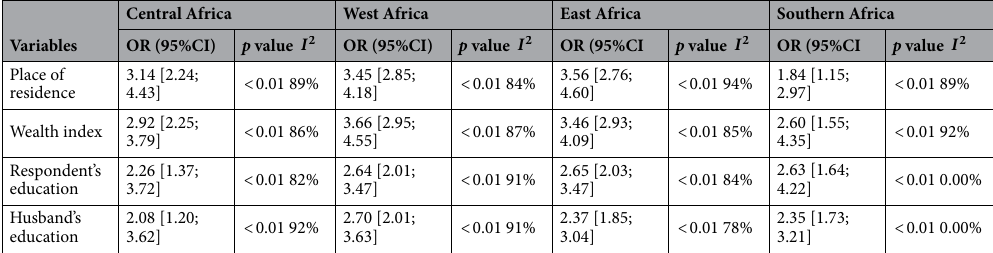
Table 5. Sub-group analysis for different factors. Q heterogenic statistic, I 2 Between study variation, OR odds ratio, CI confidence interval.